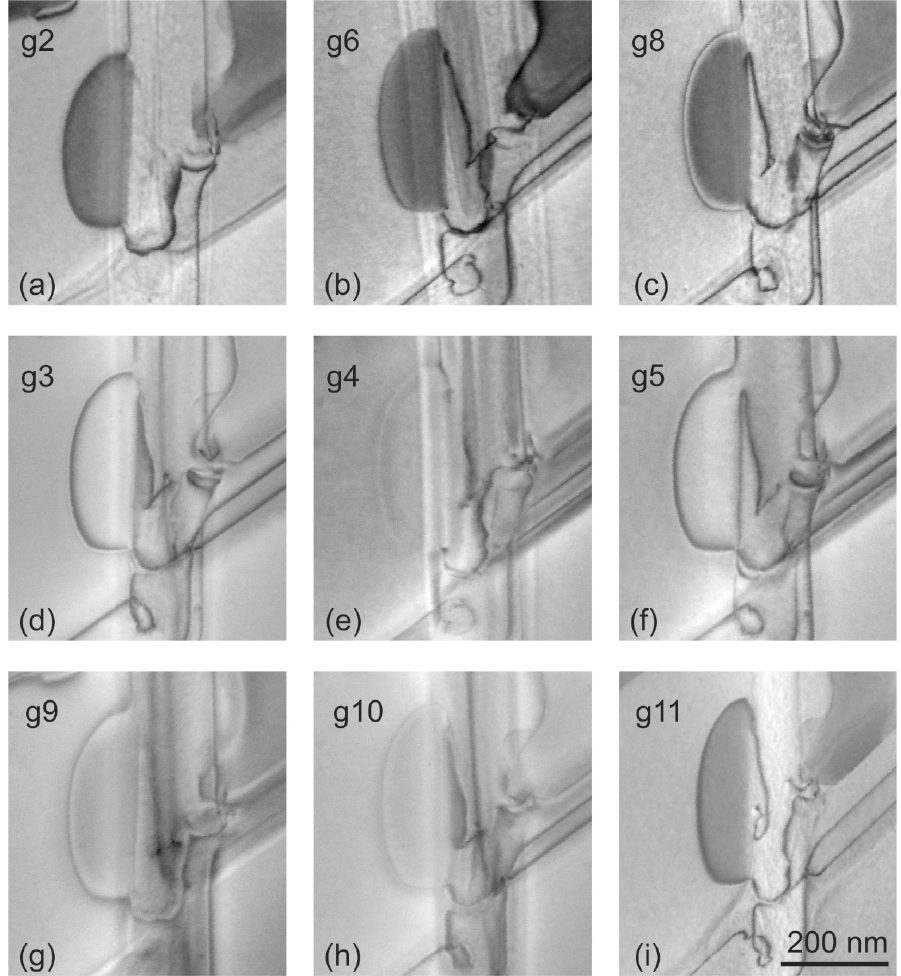
Figure 6. Nine STEM micrographs taken at different g-vectors of the cutting event marked with a white arrow in Figure 7b. ( a ) g2 = ( 111 ) . ( b ) g6 = ( 111 ) . ( c ) g8 = ( 111 ) . ( d ) g3 = ( 022 ) . ( e ) g4 = ( 220 ) . ( f ) g5 = ( 202 ) . ( g ) g9 = ( 311 ) . ( h ) g10 = ( 131 ) . ( i ) g11 = ( 020 )